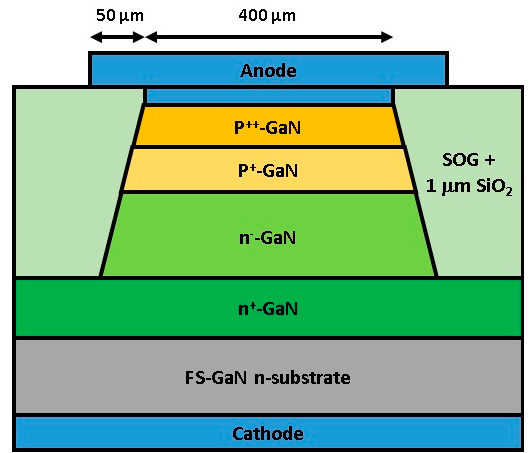
Figure 2. The schematic epitaxy structure of a vertical GaN p - i - n diode.